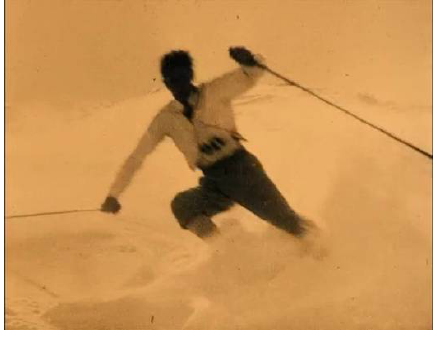
Figure 2. Still from Der heilige Berg .